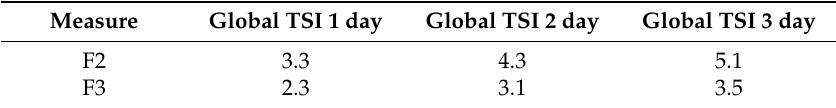
Figure11. TSI for F2 and F3 at day one for the bottom, center, and top of the vial. Figure 11. TSI for F2 and F3 at day one for the bottom, center, and top of the vial. Table 11. Global TSI for F2 and F3 at days one, two, and three. Table 11. Global TSI for F2 and F3 at days one, two, and